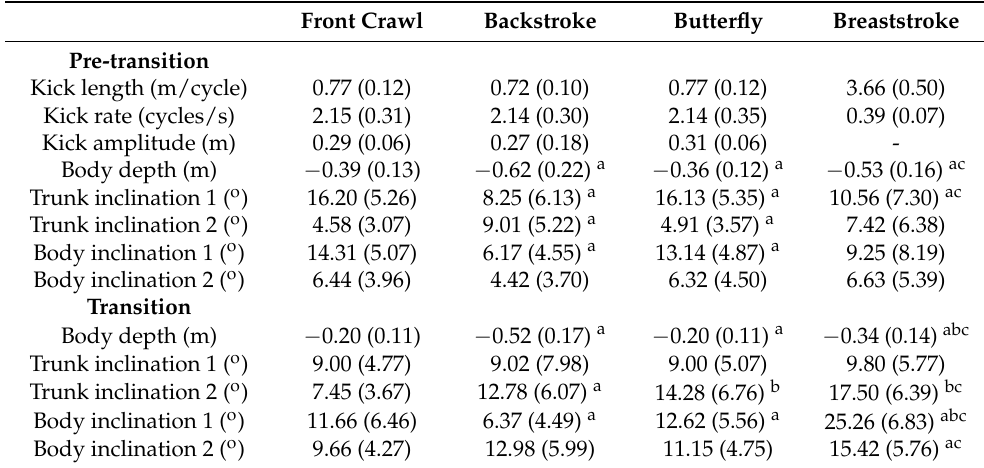
Table 1. Segmental kinematics—mean (standard deviation)—of competitive swimmers when transit- ing from underwater to surface swimming in all four strokes.